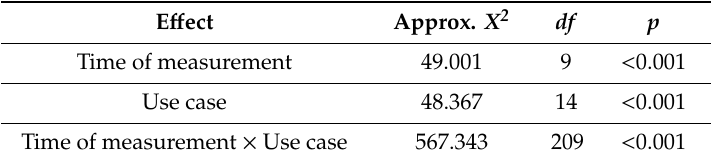
Figure 3. Means and standard errors for difficulty ratings in the 6 use cases by time of measurement (x-axis) and feedback condition (blue: additional feedback; red: no feedback). Table 5. Mauchly-test statistics of sphericity assumption for perceived ease of use.